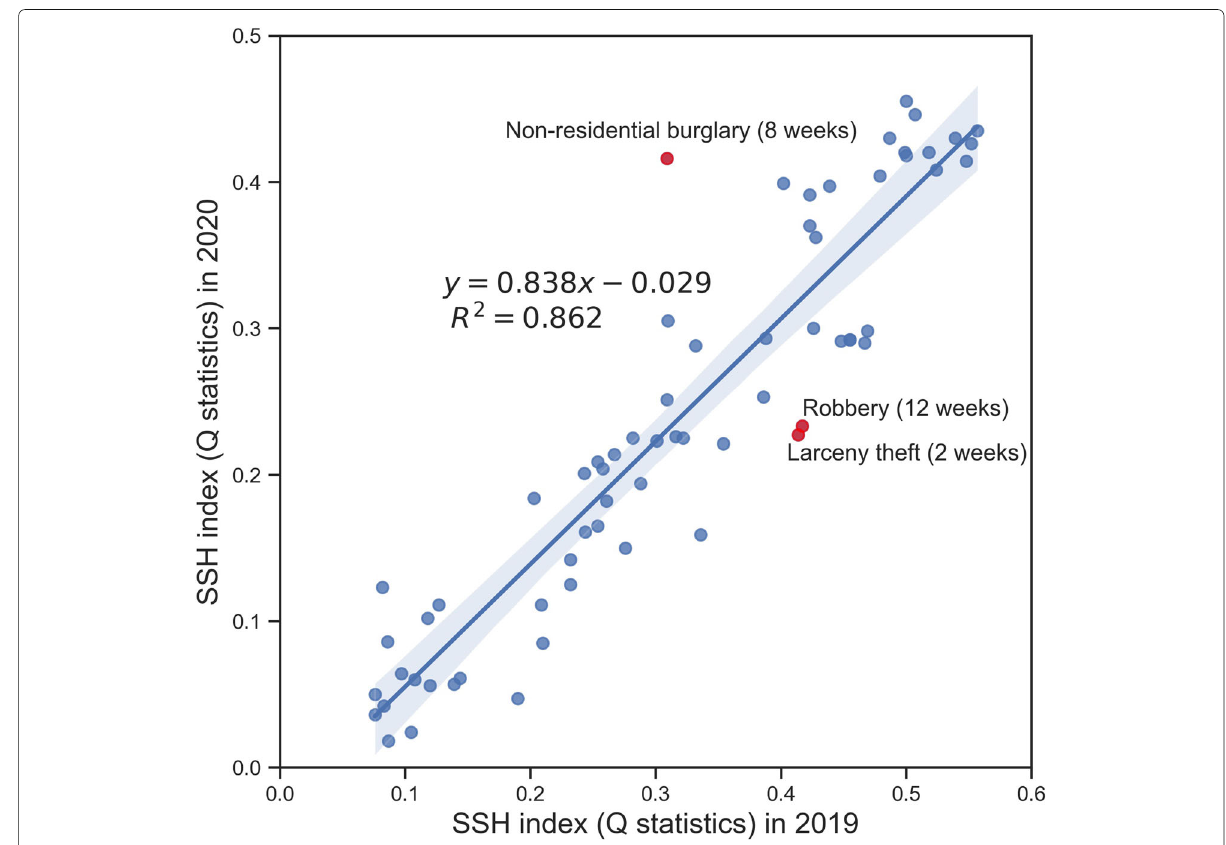
Fig. 4 Linear regression of STSH index (Q statistics) between 2019 and 2020 (The shadow area represents confident interval of